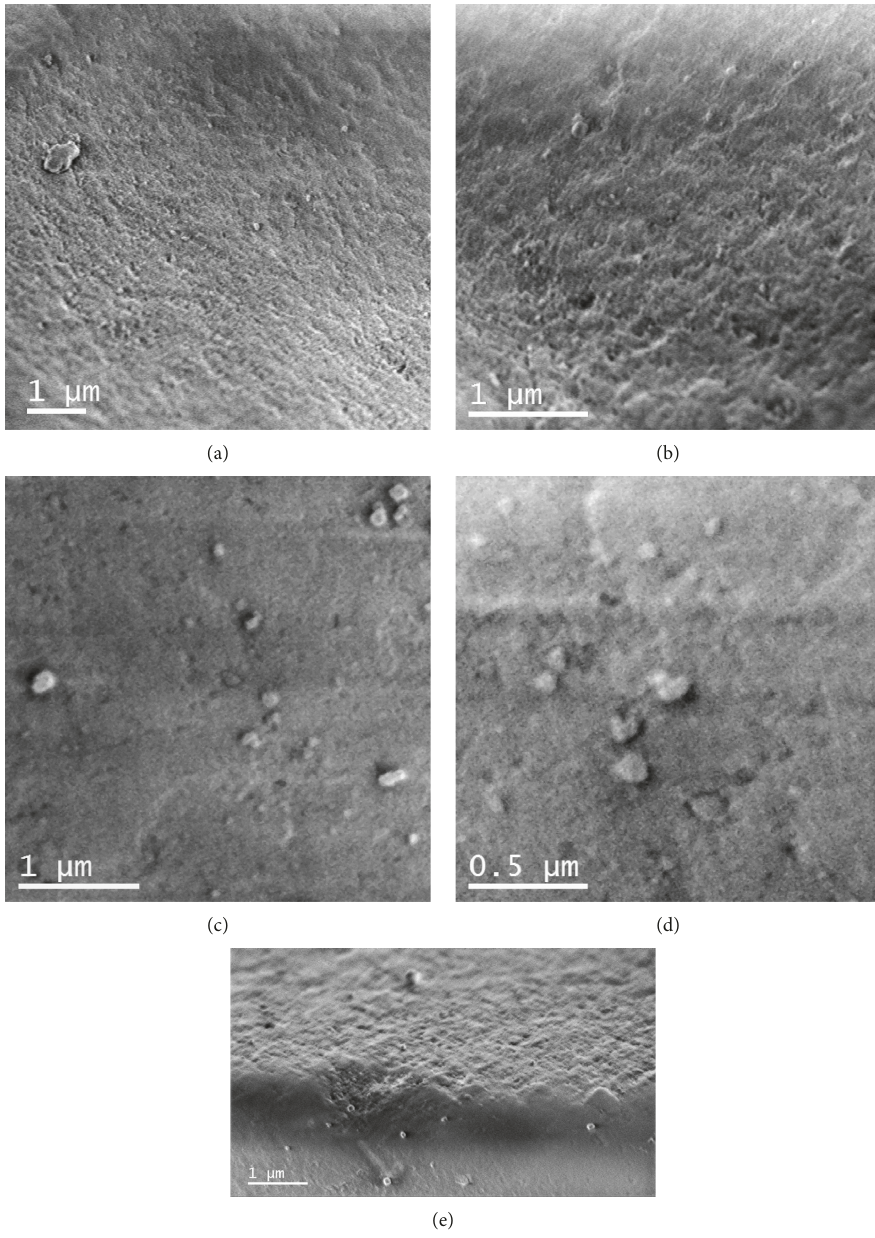
Figure 4: Scanning electron microscopy (SEM) images of (a, b) uncoated silica at different magnifications, (c, d) coated silica at different magnifications, and (e) polymer-coated silica, observation at crazing